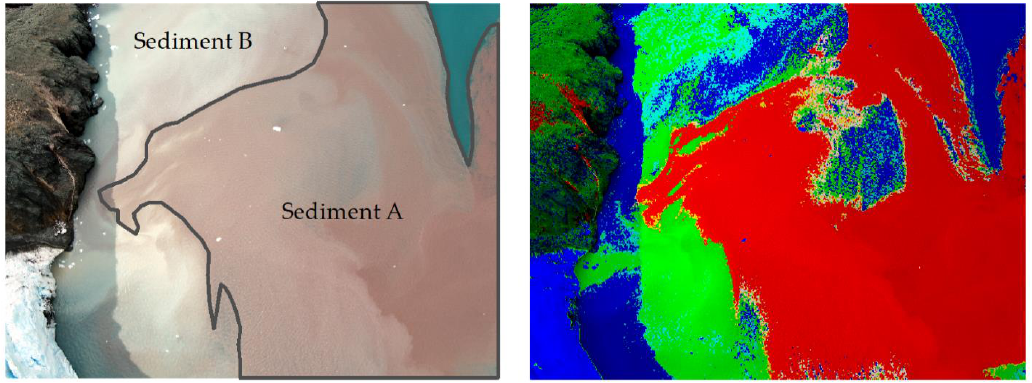
Figure 6. An example of an application of the maximum RGB algorithm.